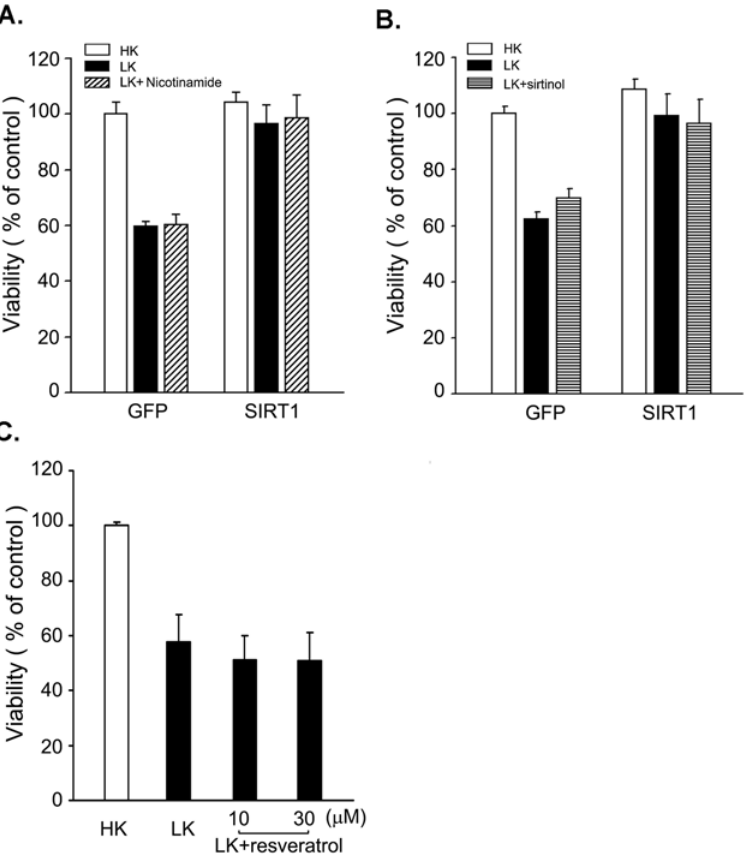
Figure 3. Pharmacological modulators of SIRT1 activity have no effect on neuroprotection. (A) Neurons treated with nicotinamide. CGNs were transfected with Flag-tagged SIRT1 or GFP control vector and the cultures switched to LK medium or LK-medium supplemented with 5 mM nicotinamide. Viability of transfected neurons (detected by Flag immunocytochemistry) was quantified 24 hours later (* indicates p , .05 compared with GFP LK; # indicates p , .05 compared with GFP HK). (B) Sirtinol does not affect SIRT1 protection. Flag-tagged SIRT1 and GFP vectors were transfected into CGNs. The neurons were then treated with LK medium or LK-medium supplemented with 100 m M sirtinol. Survival for SIRT1- transfected neurons was assessed using immunocytochemistry and DAPI staining 24 hours following treatment (* indicates p , .05 compared with GFP LK; # indicates p , .05 compared with GFP HK). (C) Resveratrol cannot rescue neurons in LK. Cultured CGNs were switched to HK medium, LK medium, or LK medium containing 10 or 30 m M resveratrol. Neuronal viability was quantified 24 hours later by DAPI staining.